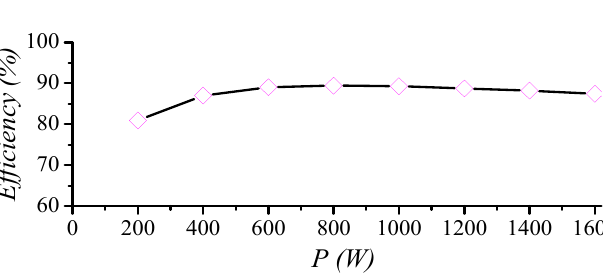
Figure 10. Grid current FFT harmonic spectrum with SOHC compensation at 1.6 kW. Figure 11. Efficiency profile of the IFBI under load variation.